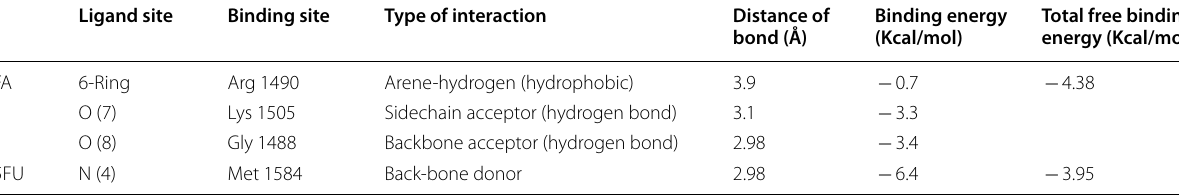
Arg arginine, O oxygen, Lys lysine, Gly glycine, Met